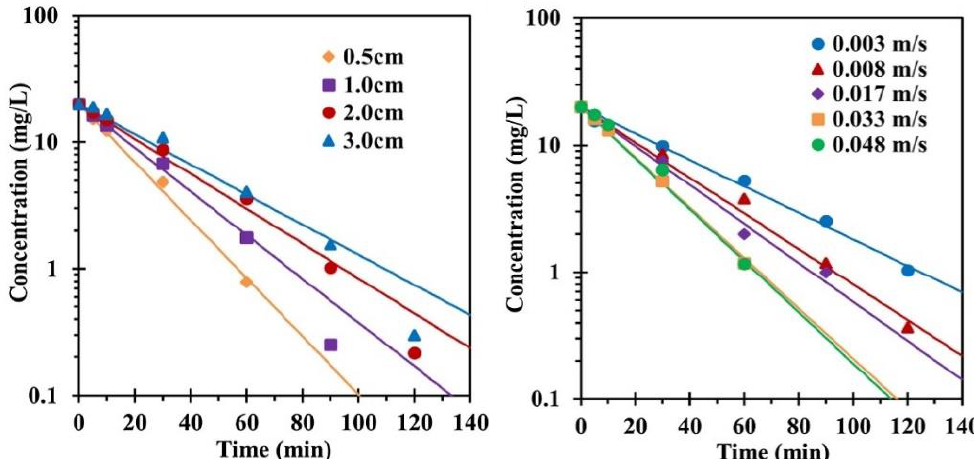
Figure 8. Effect of electrode spacing and fluid velocity on ofloxacin degradation. Anode surface area 10 cm 2 , electrolyte concentration = 0.05 M Na 2 SO 4 solution, j = 30 mA cm −2 , initial ofloxacin concentration 20 mg/L, voltage 6.2–6.3 V, initial pH 6.25, temperature 25 °C. Reprinted from Xie et al. [65], copyright © (2017) with permission from Elsevier.